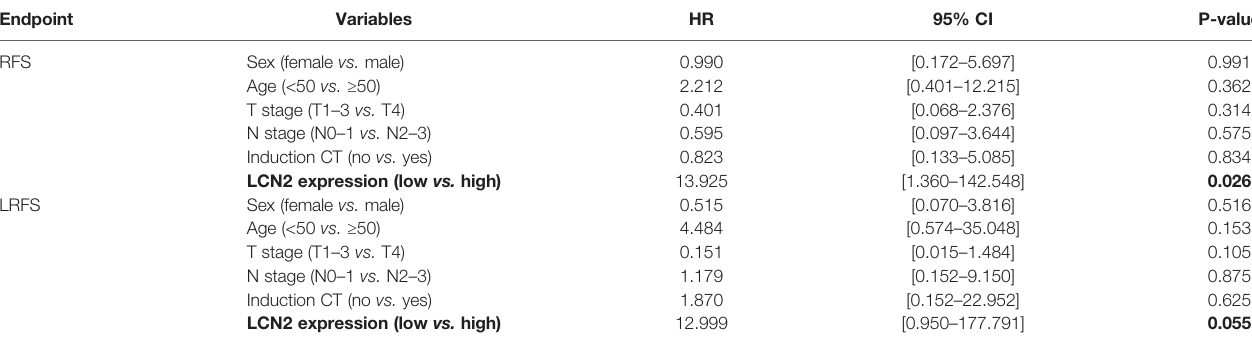
TABLE 2 | Multivariate analysis using a Cox proportional hazards model for the RFS and LRFS of NPC patients. Endpoint